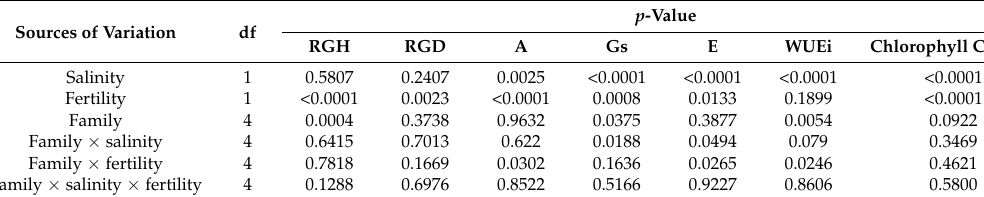
Table 2. Analysis of variance (ANOVA) results for the response of different Senegalia senegal families to salinity and fertility for leaf gas exchanges (net photosynthetic rate (A), stomatal conductance (G s ), transpiration (E), and intrinsic water use efficiency (WUE i )), relative growth of height (RGH) and diameter (RGD), and chlorophyll content.